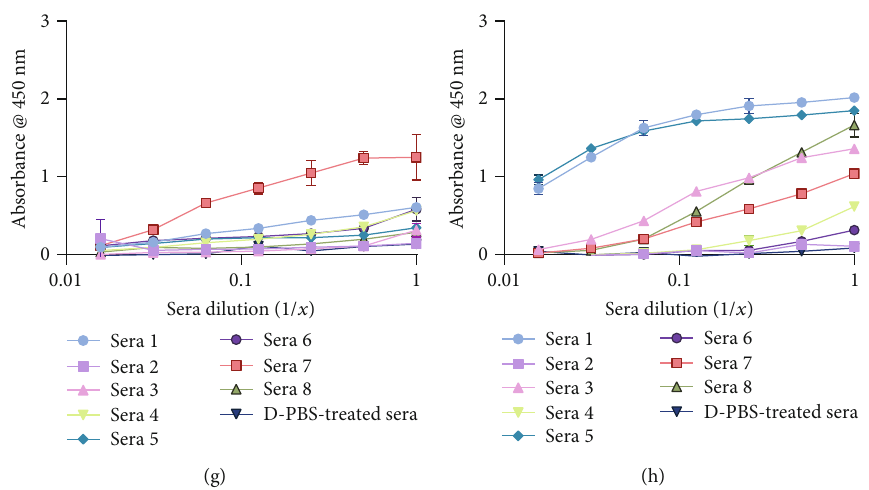
Figure 3: Indirect capture ELISA determination of anti-hTNF- α drugs and drug-mouse ADA complexes in individual mouse serum samples . (a and e) Detecting and quantifying serum Quad-X ™ in 1mg/kg and 3 mg/kg treated mice serum samples diluted at 1 :40 and 1: 100 in sterile PBS, pH 7.4, respectively, prior to adding to designated ELISA wells. Standard anti-hTNF- α Quad-X ™ (Quad-X ™ Std) was used at a top known concentration of 0.1 μ g/mL. (b and f) Detecting and quantifying serum Humira® in 1mg/kg and 3mg/kg treated mice serum samples diluted at 1: 20 and 1 :100 in sterile PBS, pH 7.4, respectively, prior to adding to designated ELISA wells. Standard Humira® (Humira® Std) was used at a top known concentration of 1 μ g/mL. ELISA wells were coated with an anti-human IgG antibody (Fc speci fi c), and detection was performed with an anti-human IgG antibody- (Fc speci fi c) peroxidase. (c and g) Indirect ELISA detection of anti-Quad-X ™ mouse ADA to Quad-X ™ in 1mg/kg and 3mg/kg Quad-X ™ -treated serum samples diluted at 1:20 and 1:50 in sterile PBS, pH7.4, respectively, prior to adding to designated ELISA wells. (d and h) Indirect ELISA detection of a mouse ADA complex to serum Humira® in 1mg/kg and 3 mg/kg Humira®-treated serum samples diluted at 1: 20 and 1 :50 in sterile PBS, pH 7.4, respectively, prior to adding to designated ELISA wells. ELISA wells were coated with an anti-human IgG (Fc speci fi c) antibody, while detection of a drug-ADA complex was performed using an anti-mouse IgG antibody- (whole molecule) peroxidase. The results shown are the mean ± SD ( n = 2 with two replicates per